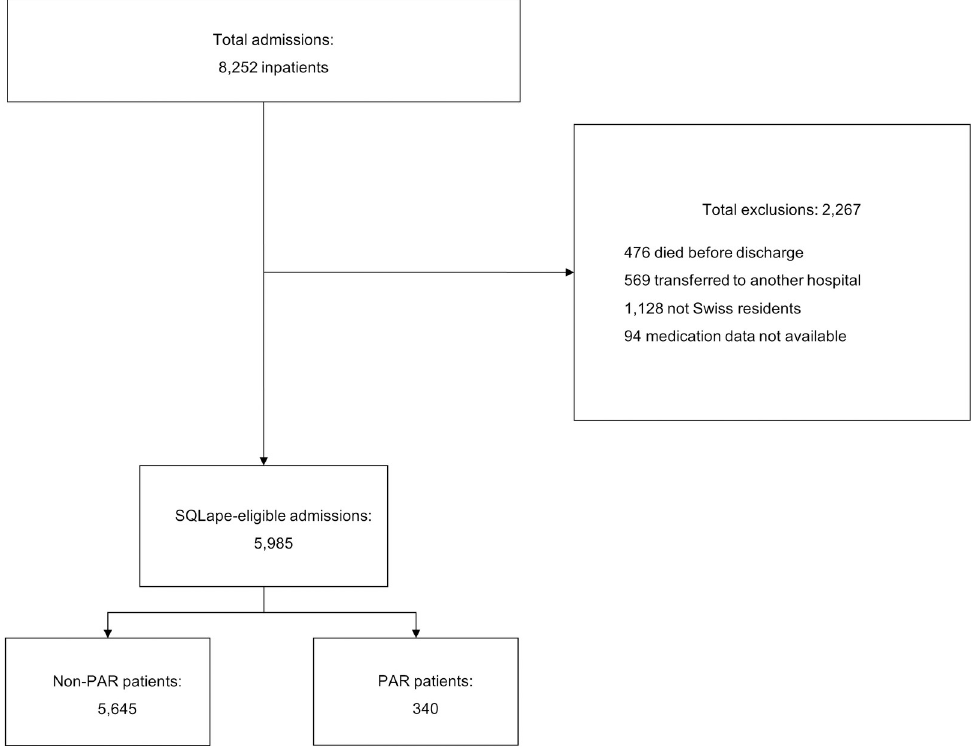
Fig 2. Dataset generation with applied exclusion